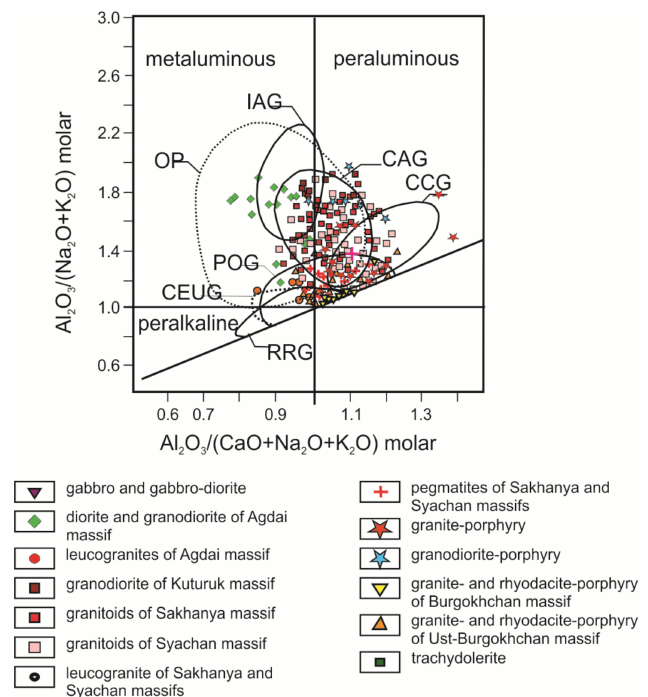
Figure 8. Alumina content in magmatic rocks of the Selennyakh River basin. Fields of the dia- gram [42]: OP—oceanic plagiogranites, IAG—island-arc granitoids, CAG—granitoids of continental arcs, CCG—continental collision granitoids, POG—postorogenic granitoids, CEUG—granitoids of continental epirogenic uplift, RRG—riftogenic granitoids.